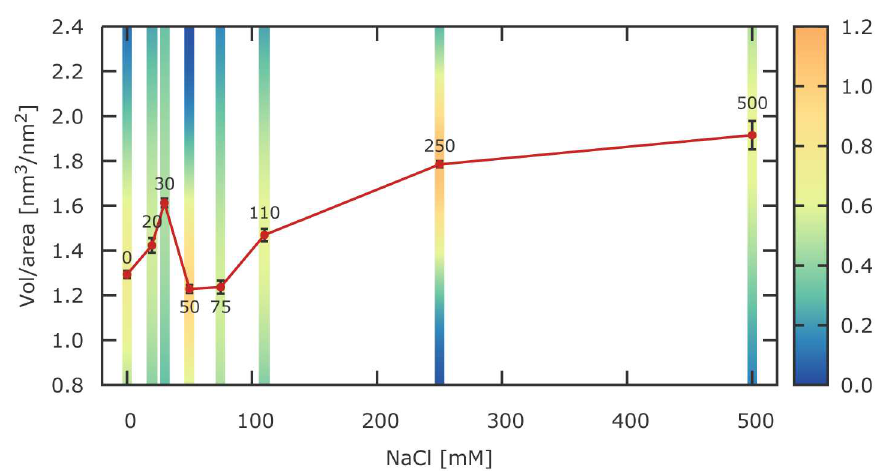
Fig 3. Salt-dependent compaction of the chromatin arrays. Depictedare the mean values of ratio betweenthe volume of arrays and the surface area occupiedby them, plotted againstincreasingNaCl concentrations (red line). Each point represents a different salt concentration and has depicted standarderror (red bars). The colourcoded stripes represent the normalised Gaussiandistribution(area equal to 1) for each salt concentration, displayinga fairly low